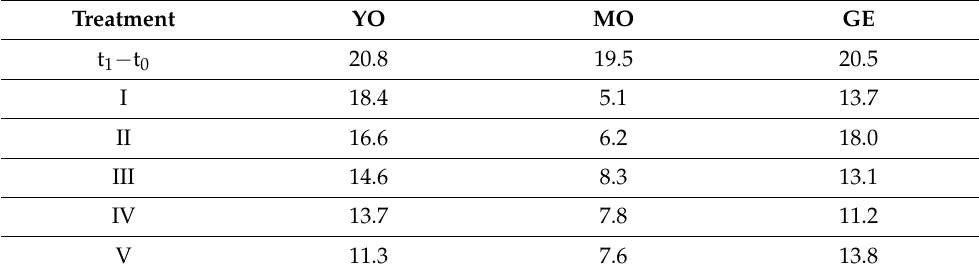
Table 7. Global color change values ( ∆ E) as a function of the paint type following the shellac